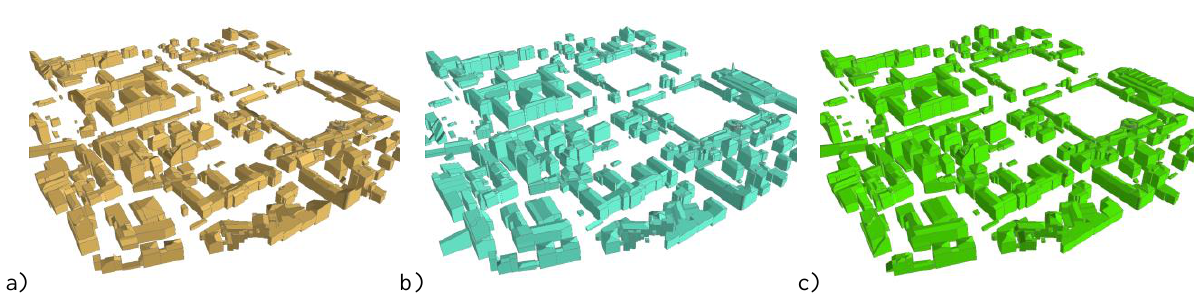
Figure 3. LoD1 prismatic building models generated using the 1:10,000 topographic map with GeoEye DSM (a), airborne images DSM (b) and LiDAR DSM (c).